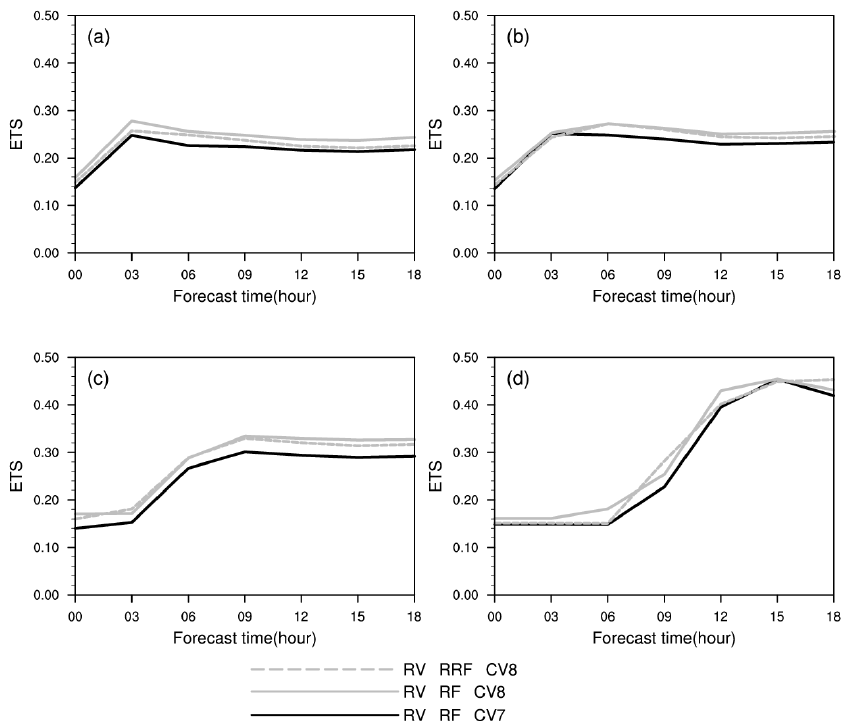
Figure 11. The equitable threat scores (ETSs) of the four experiments for the thresholds of ( a ) 15 mm, ( b ) 25 mm, ( c ) 40 mm, ( d ) 50 mm for RV_RF_CV7, RV_RF_CV8, and RV_RRF_CV8, respectively.